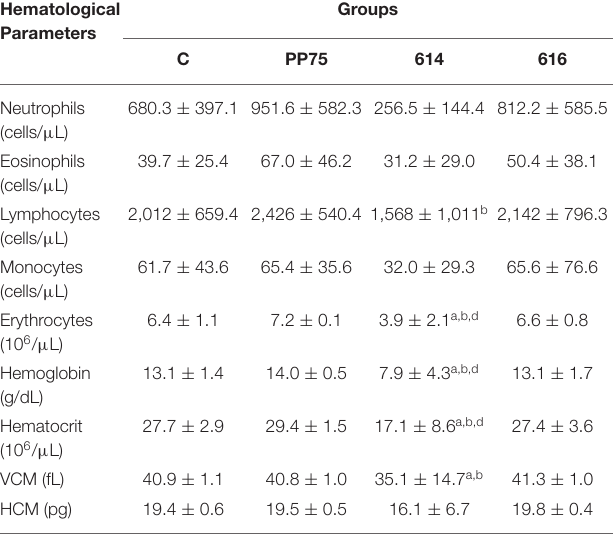
TABLE 2 | Hematological profile from non-infected animals (C; control group) and experimentally L. infantum- infected groups (reference strain: PP75; and wild strains: 614 and